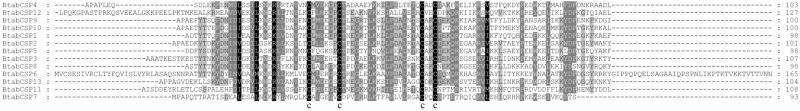
Alignment of the identified B. tabaci CSPs.Full-length amino acid sequences of B. tabaci MED CSPs are aligned by Clustal X 2.1. Black boxes show conserved cysteines. The conserved Cys residues are indicated.